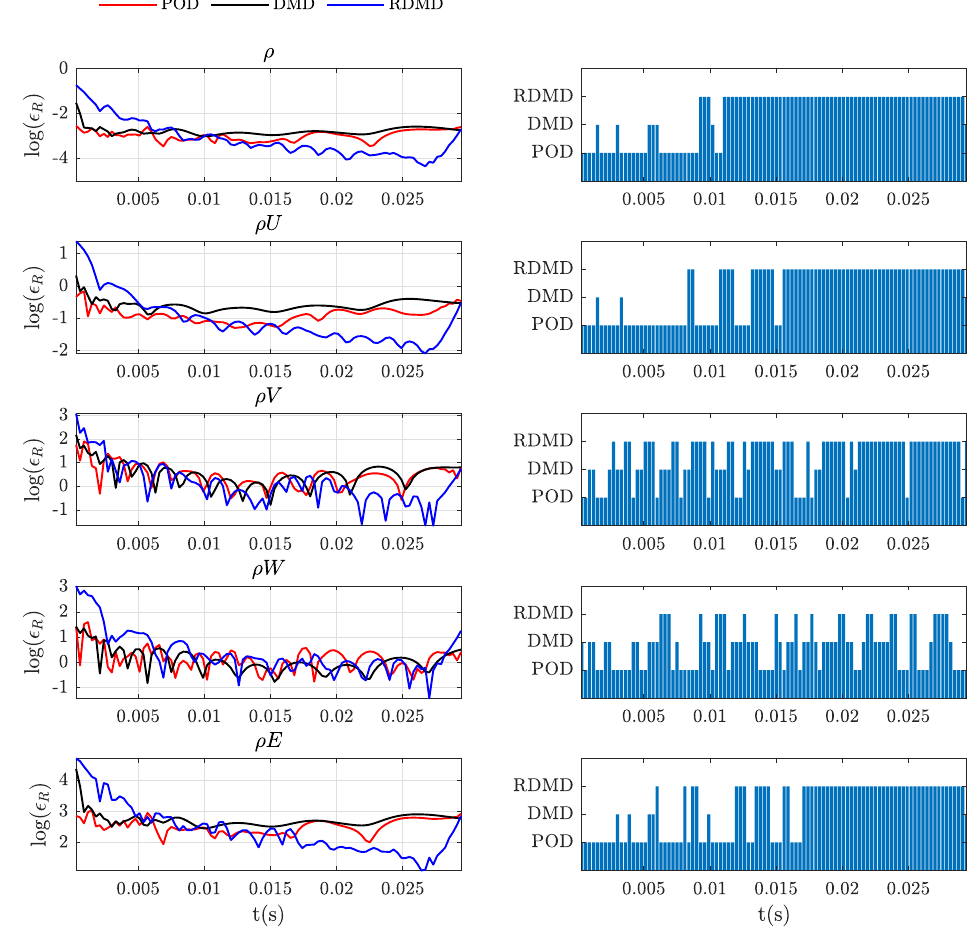
Figure 22. Volume residual evaluation ( left column) and choice of methods ( right columns) for all the conservative variables (excluding turbulence), fixed number of modes N m = 15, formation flight test